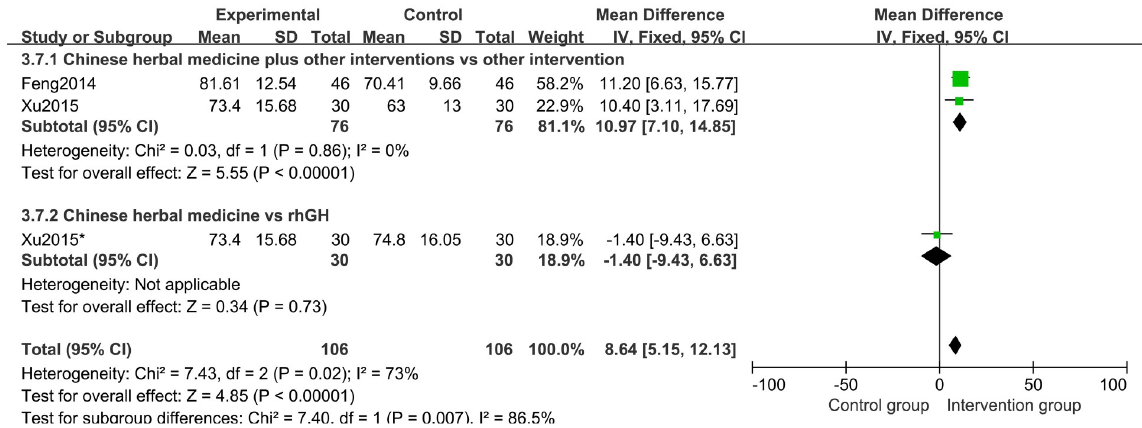
Fig 16. Subgroup analysis of osteocalcin based on the interventions.